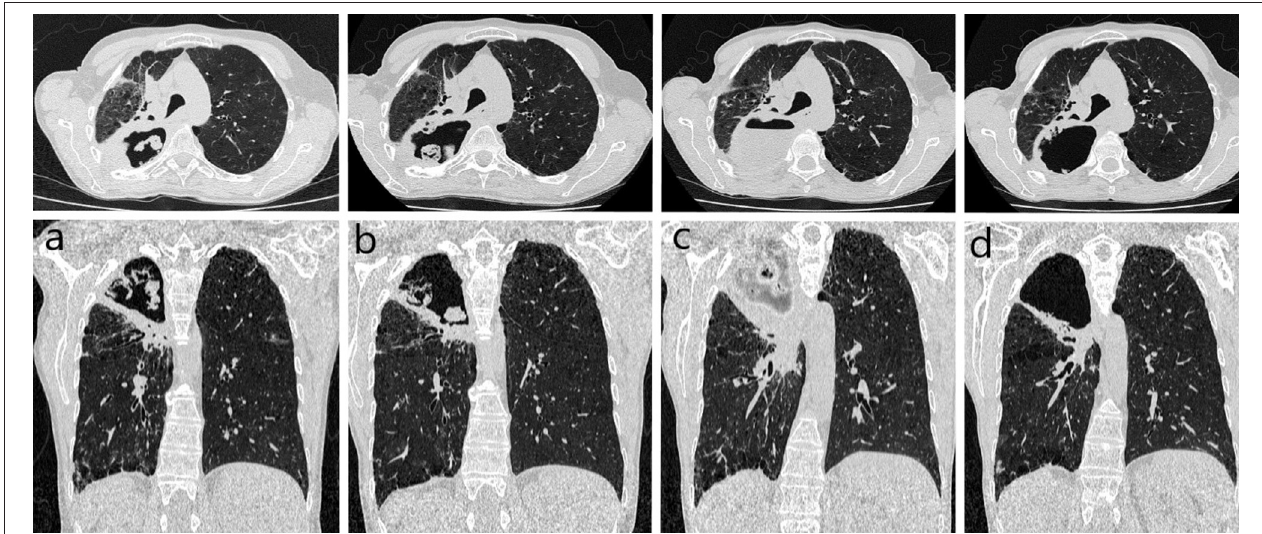
FIGURE 5 | Controlled chest CT during second-line treatment in 2021: (a) at the beginning of the therapy – cavity with thick walls size 69 × 47mm, concomitant mass on the posterior wall-size 22 × 9mm, quantitative progression of the surrounding consolidations compared to the previous image; (b) after 3 months – cavity size 70 × 66mm, the mass inside larger and more irregular (progression); (c) after 4 months – circumscribed opacity with an air-fluid level size 95 x 75mm in the place of the previously described cavity (further progression, abscess); (d) after 5 months – cavity with thick wall much smaller, the mass inside size 28 × 20mm, no fluid was visualized (regression).